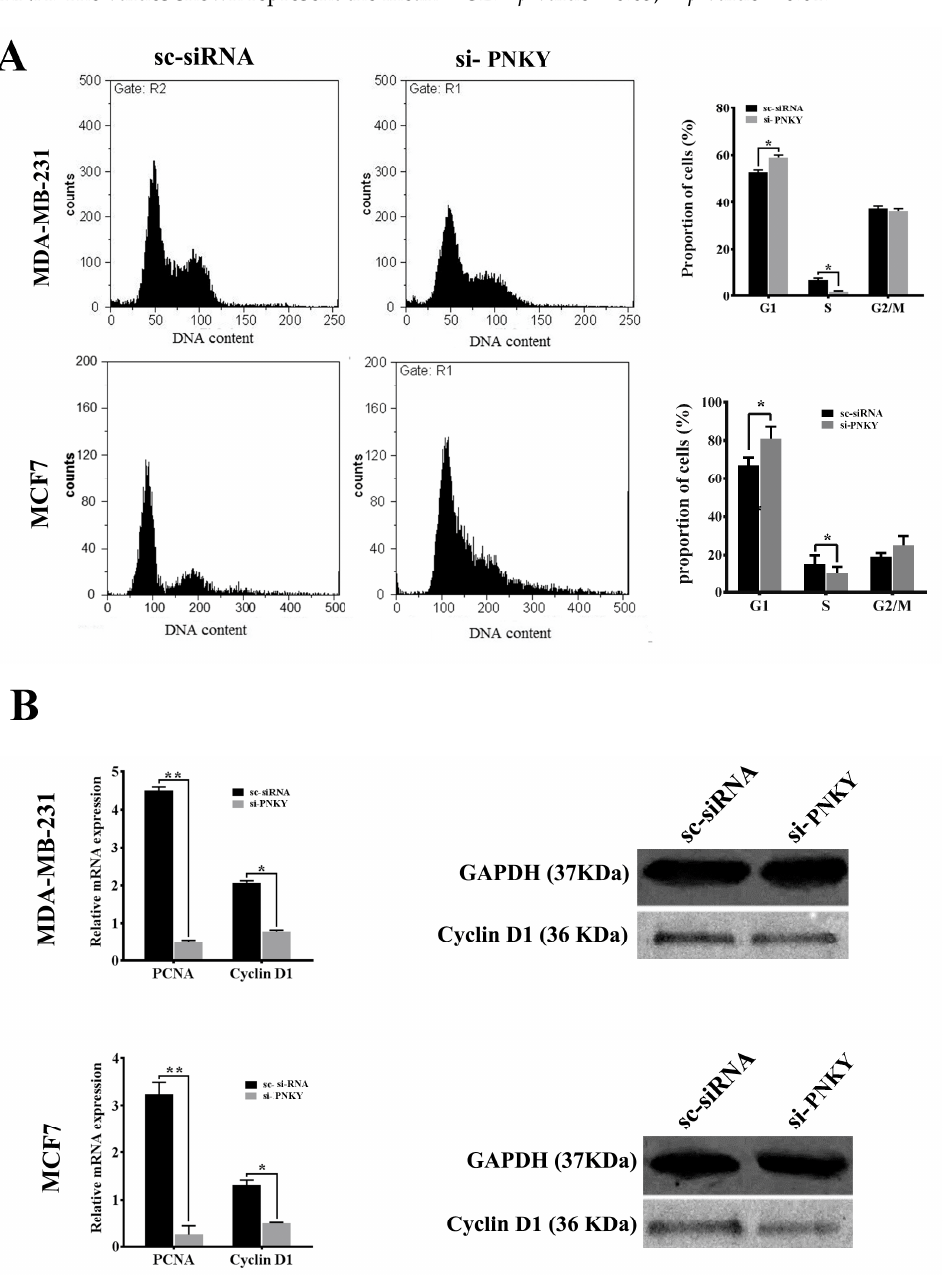
Figure 3. Knockdown of PNKY induces cell cycle arrest in MCF7 and MDA-MB-231 cell lines. ( A ) Cell cycle analysis of MDA-MB-231 and MCF7 cells indicates that the proportion of cells in the G1 phase of the cell cycle increased when PNKY was suppressed. ( B ) RT-qPCR analysis of PCNA and Cyclin D1 revealed that these transcripts significantly downregulate after PNKY is knocked down. In addition, the western blotting analysis showed that the expression level of Cyclin D1 significantly decreased following the downregulation of PNKY. The values shown represent the mean ± SE. * p value < 0.05, ** p value < 0.01.